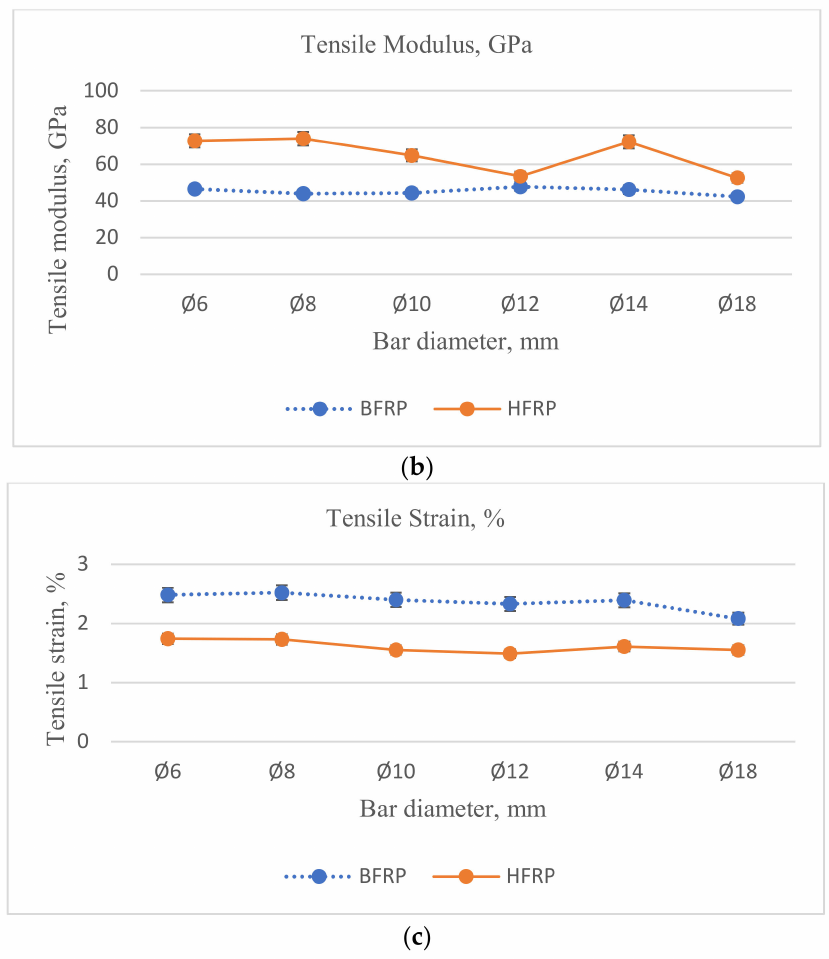
Figure 4. Mechanical properties of FRP bars obtained from tensile testing: ( a ) Tensile strength, ( b ) Modulus of elasticity, ( c ) Tensile